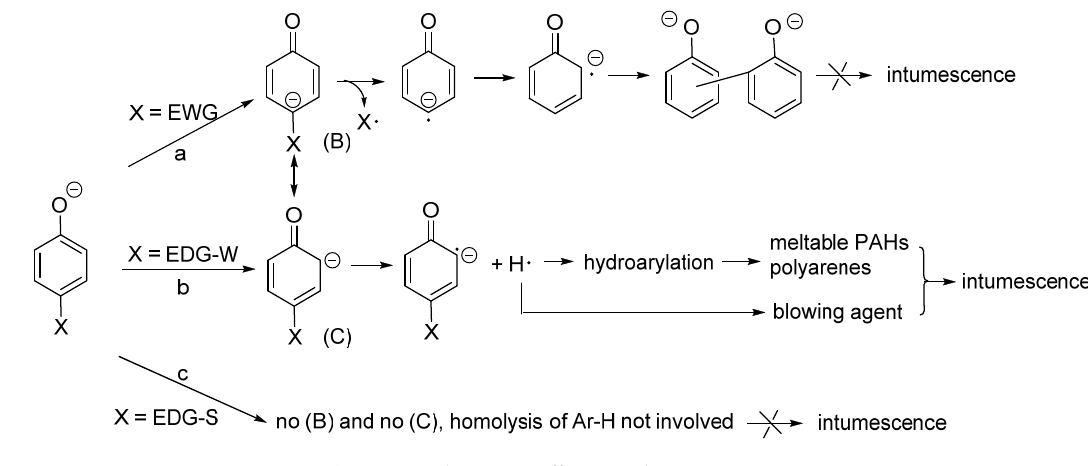
Scheme 7. Substituent e ff ects on the